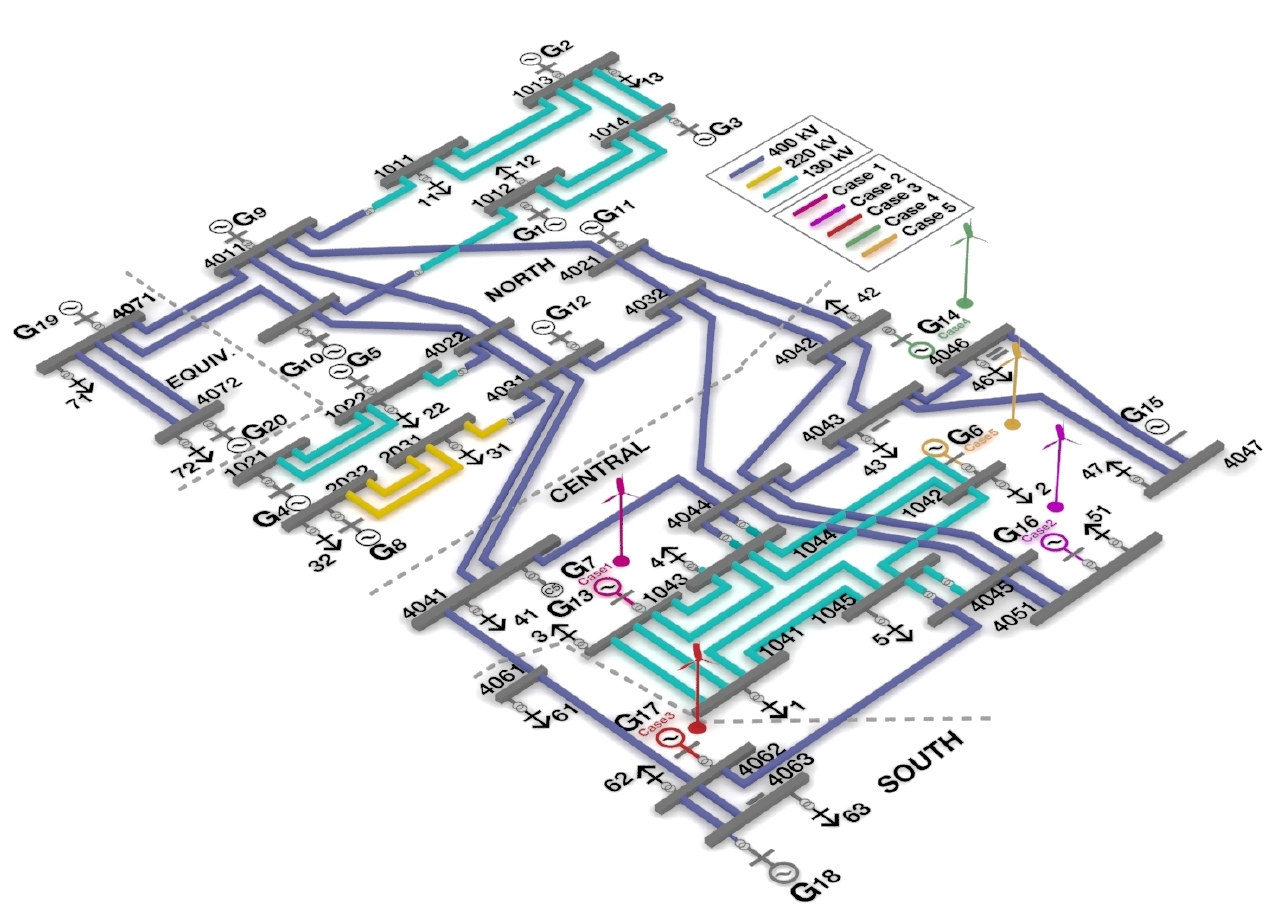
Figure 3. Full Rated Converters